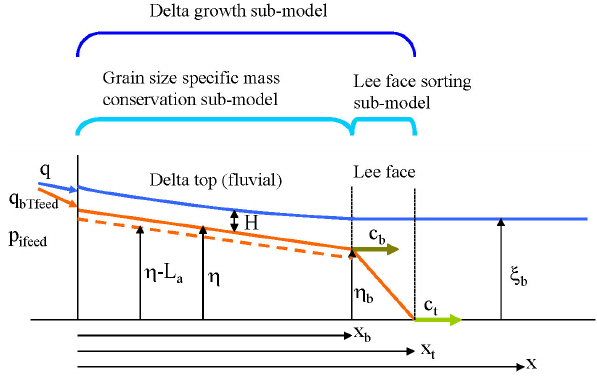
Figure 3. The numerical sub-models and the relevant model param- eters. x is a streamwise coordinate, x b and x t are the coordinates of the brinkpoint and of the delta toe. H is the water depth on the delta top. q is the input water discharge per unit channel width, q bTfeed is the total (i.e., summed over all the grain sizes) volumetric sediment feed rate per unit channel width, p ifeed characterizes the grain size distribution of the fed material, and ξ b is the elevation of the down- stream standing water above the datum. η represents the elevation of the delta top above the datum, η b is the elevation of the brinkpoint, and L a denotes the active layer thickness. c b denotes the migration rate of the brinkpoint, and c t is the migration rate of the delta